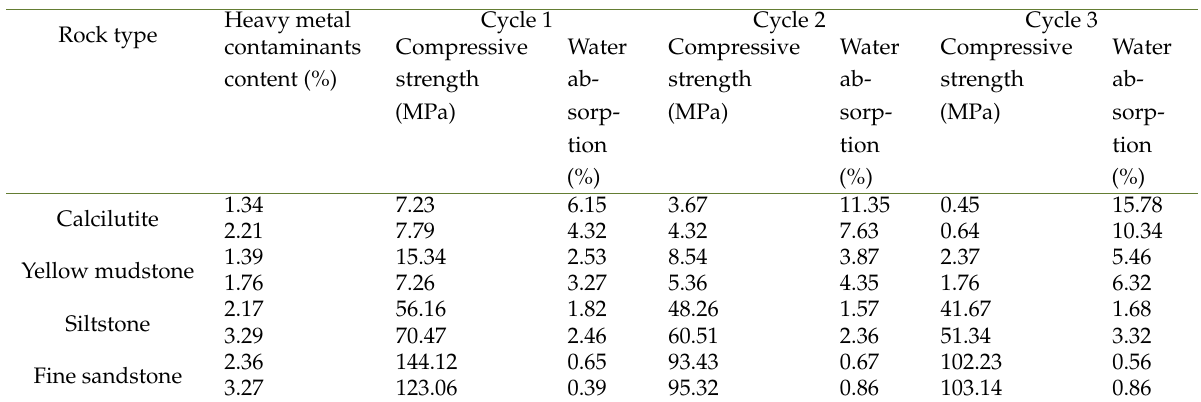
Table 2. The results of weathering durability